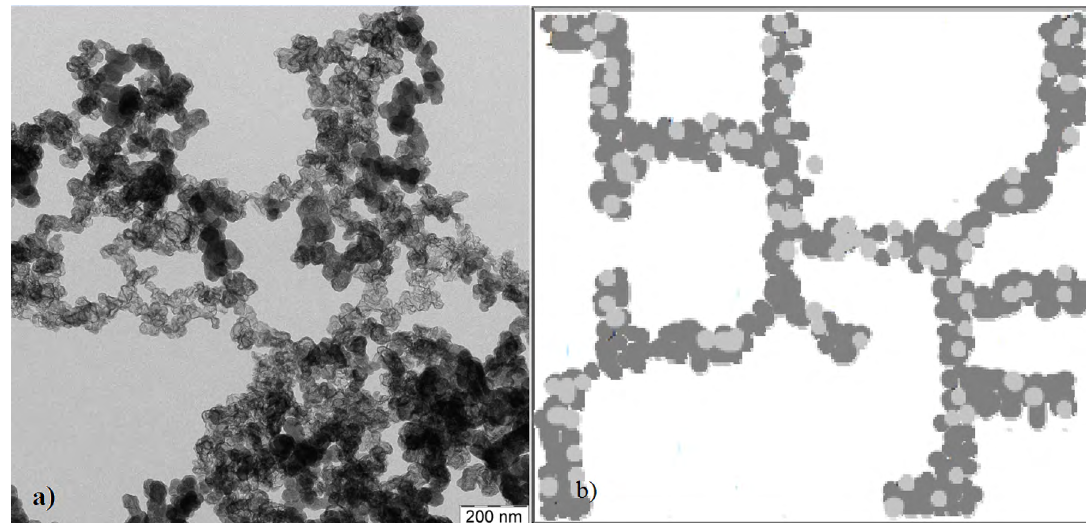
Figure 6. (a) Morphology of CB and (b) Representation of CB